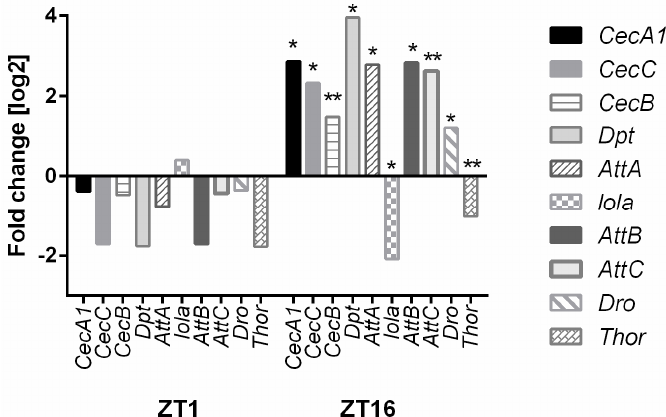
Figure 3. Microarray data of the circadian clock gene expression. Differences in the selected gene expression levels are shown between GMR> hoRNAi and GMR> Valium10 (control) at ZT1 and ZT16. The following genes were examined: clk , cry , tim , per, Pdp1, vri, cwo, and E23. Fold change is relative to the control. Statistically significant difference are marked with asterisks: * 0.005 < p -values < 0.05.